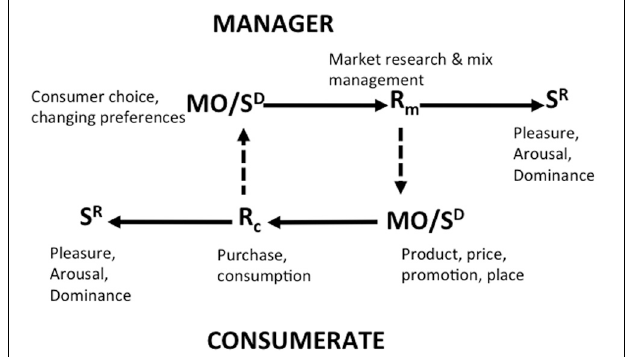
FIGURE 4 | Bilateral Contingency between the Marketing Firm (the Marketer) and the its Consumerate. FIGURE 5 | Bilateral contingency between a manager within the